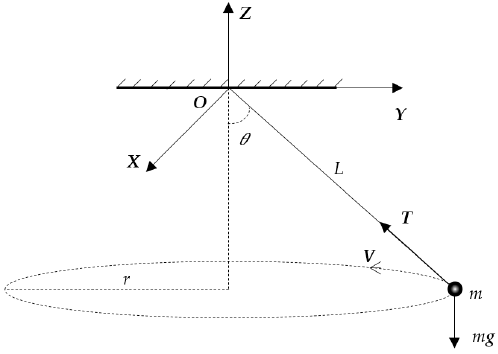
Figure 3. Sketch of polyethylene rubber conical pendulum system.